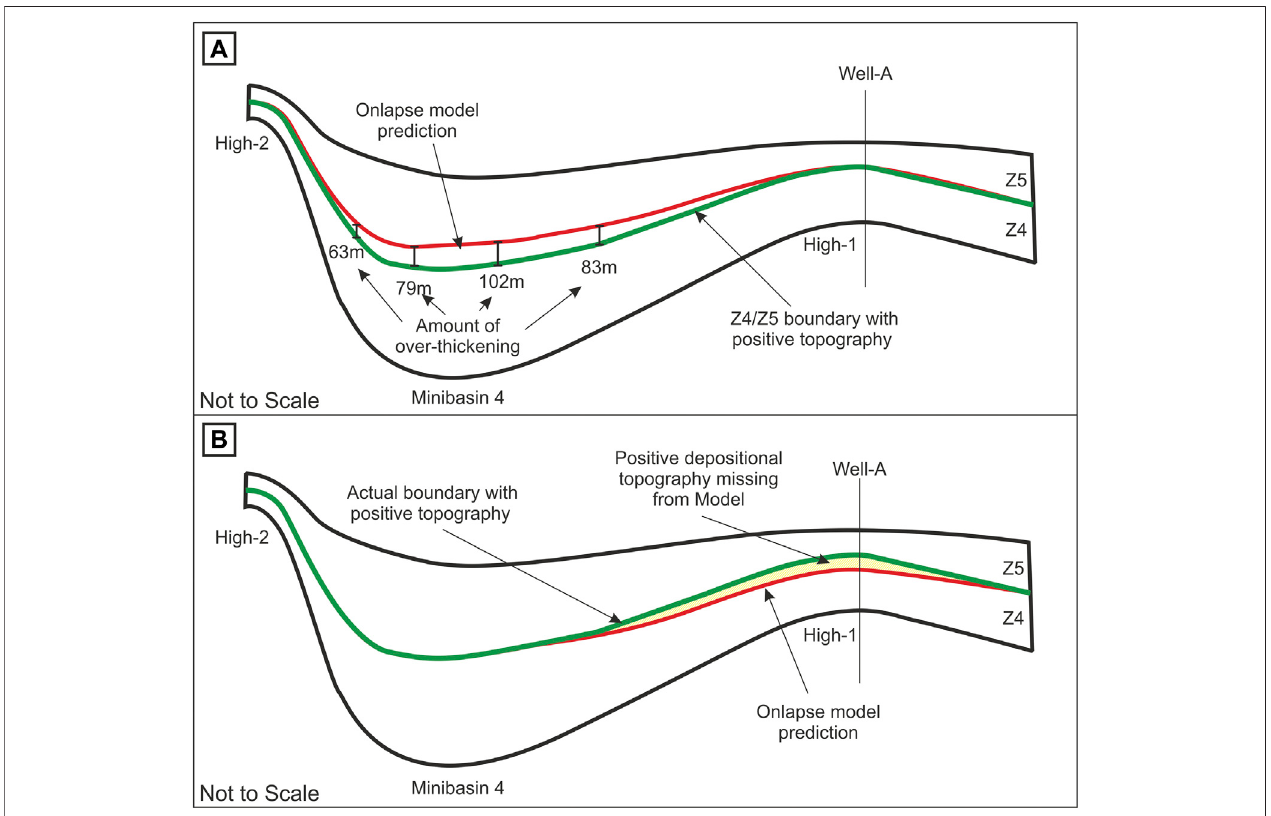
FIGURE15|(A) SchematicdiagramofmismatchbetweentheOnlapse-2Dsimulationandseismicdata,withsigni fi cantover-thicknesswithinMinibasin4fromLine 2. Red horizon represents the original simulated boundary between Zone 4 & 5 within the model. Green horizon represents boundary between Zone 4 & 5 with positive depositional topography taken from seismic data. (B) Schematic diagram of Onlapse-2D in fi nal simulation of the same line, red horizon represents Onlapse-2D simulated horizon, which now matches the boundary seen in seismic in Minibasin. From the difference between red and green horizon on High-1 we can infer the amount of positive depositional topography that is